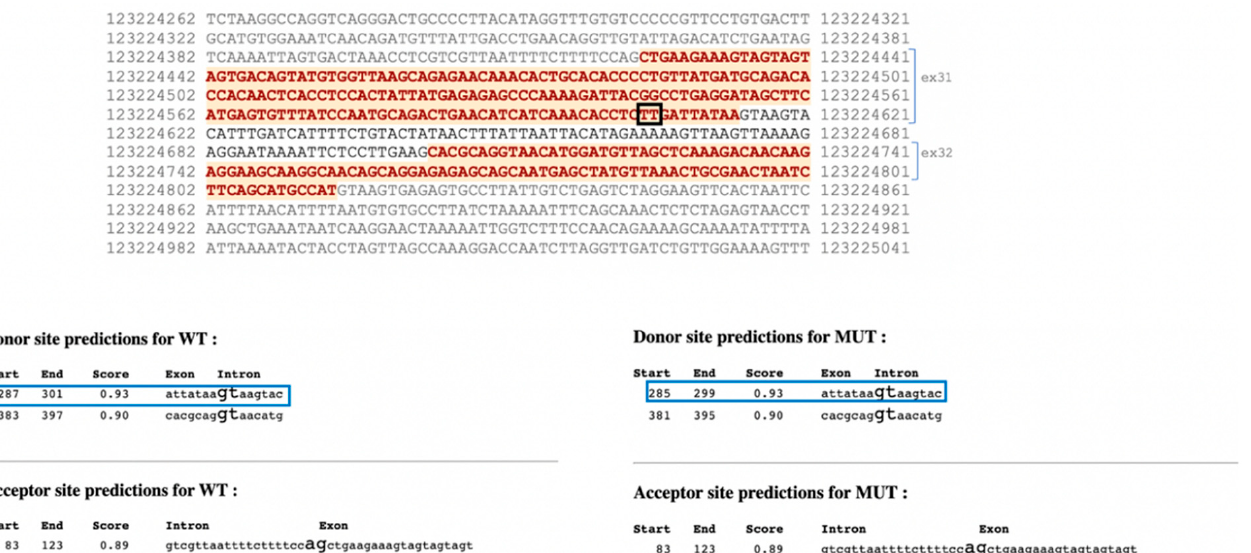
Figure 3. Top: Exon-intron sequences 31 and 32 of the STAG2 gene. The coding regions are in bold red. The two deleted bases, 9 nucleotides upstream of the splice donor site, are highlighted in